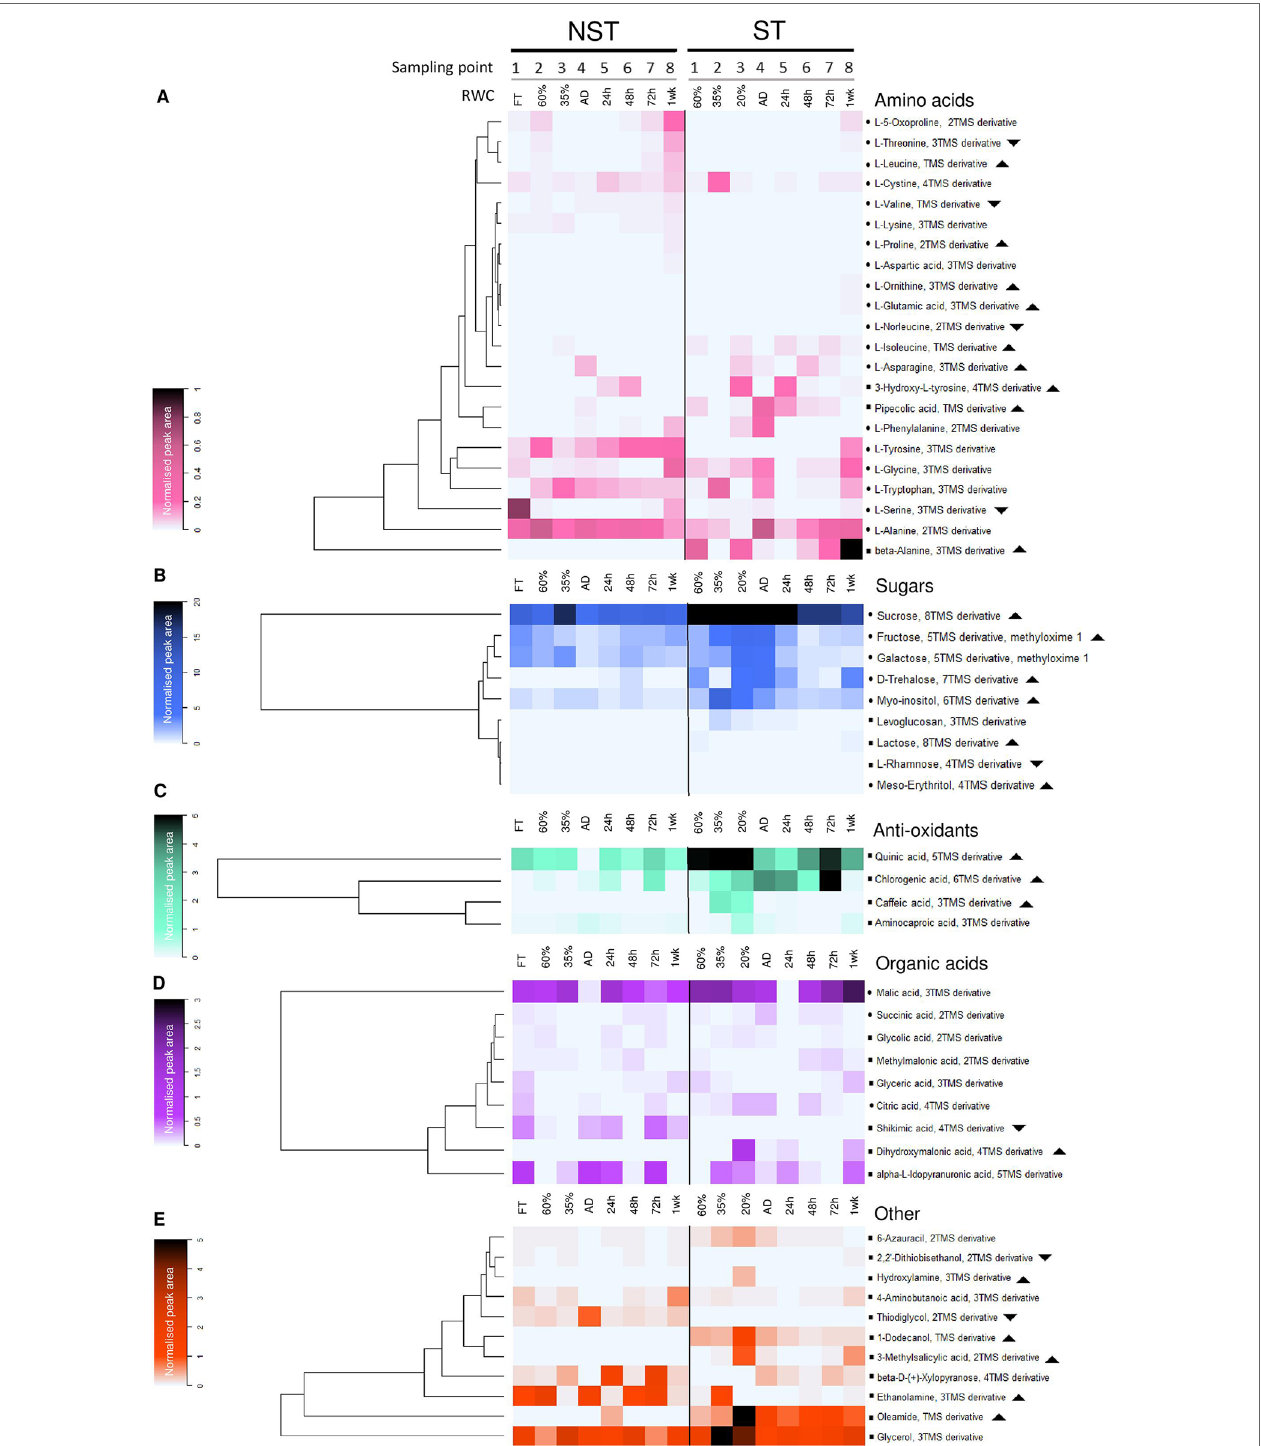
FigURe 5 | Desiccation associated responses in the metabolome of non-senescent tissues (NST) and ST as determined by gas chromatography–mass spectrometry. Average peak area of compounds identified in this study, normalized to ribitol internal standard and sample dry masses. Note that for each sampling point (1-8), ST and NST from the same leaves differ in average RWC. In each of the compound classes is a dominant (highly accumulated) metabolite: alanine (A) , sucrose (B) , quinic acid (C) , malic acid (D) , and glycerol (e) . Symbols: indicates compound identification was done using the National Institute of Standards and Technology (NIST) library and an internal library of standards; indicates NIST library identification only; indicates significantly greater total accumulation in ST vs. NST (log 2 fold change ≥2, t-test p ≤ 0.05, FDR ≤ 0.1); indicates significantly lesser total accumulation in ST vs. NST. AD refers to the airdry state.